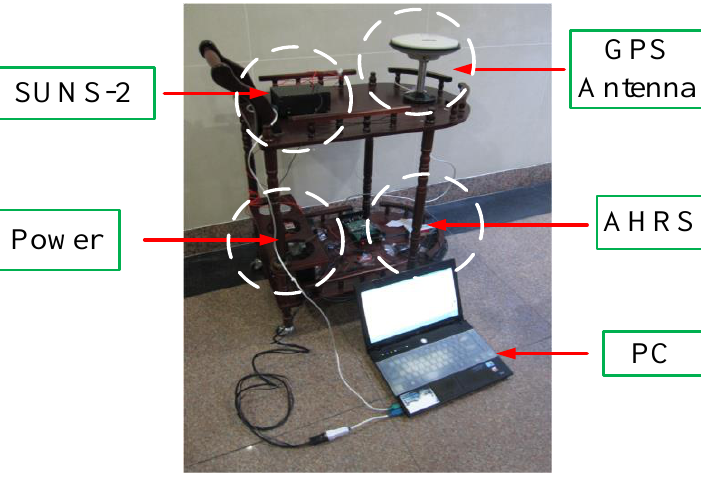
Figure 4. The vehicle experiment platform.